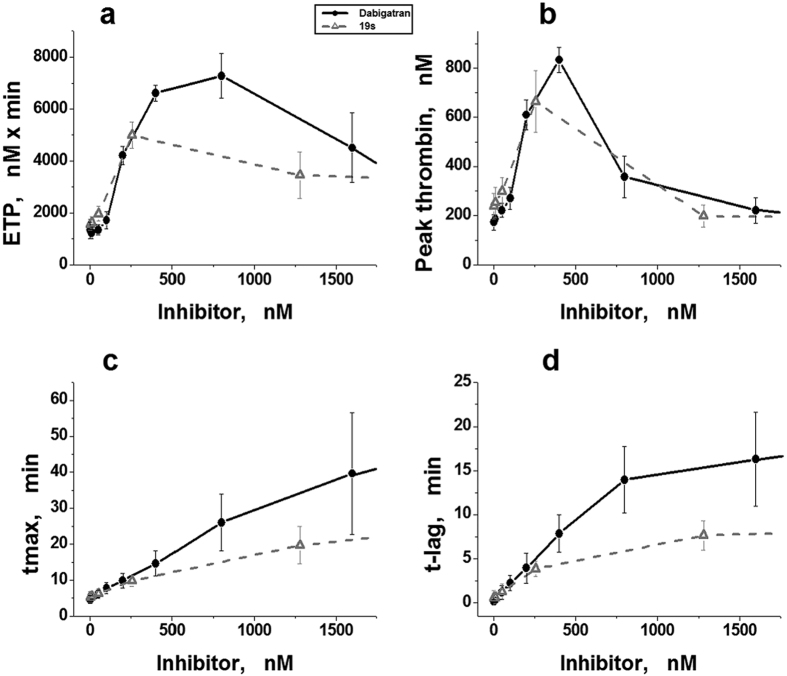
Parameters of TGT in the presence of DTIs determined by CAT in donor plasma.(a–d) Endogenous thrombin potential (ETP), maximal thrombin concentration in the sample (peak thrombin), time to maximal concentration (tmax), and time to thrombin concentration 10 nM (t-lag) plotted against concentrations of dabigatran (•, black solid line), or thrombin inhibitor 19 s (Δ, grey dashed line). Mean values ± SD (n = 5) are presented. Different plasma sets were used in the groups of different inhibitors.